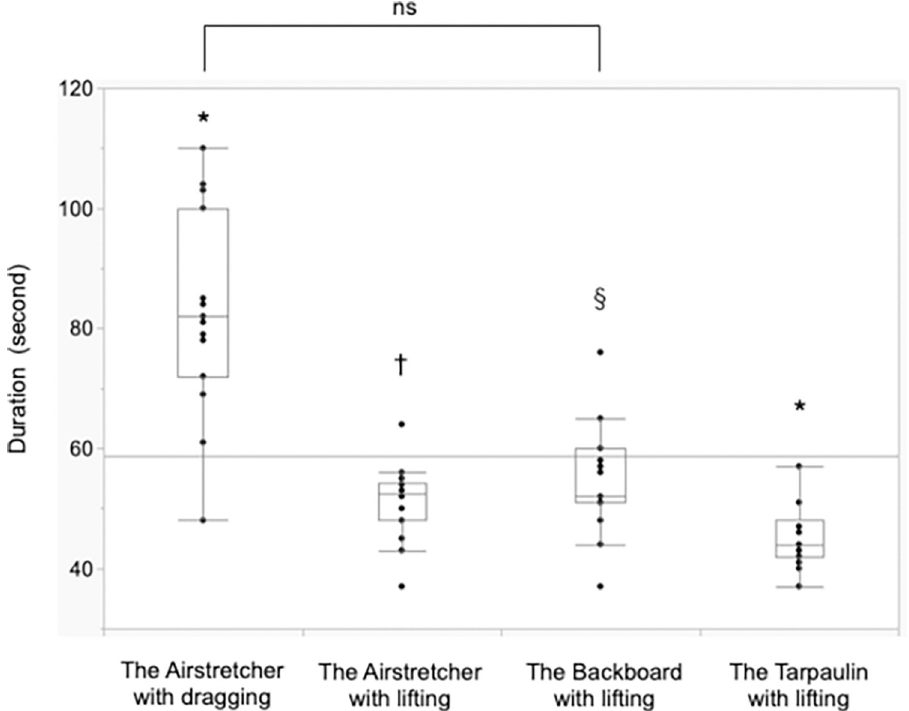
Fig 5. Duration of carrying. � Compared with others ( p < 0.01). † Compared with the Airstretcher with dragging ( p < 0.01) and the Tarpaulin with lifting ( p < 0.05). §Compared with the Airstretcher with dragging ( p < 0.01) and the Tarpaulin with lifting ( p <